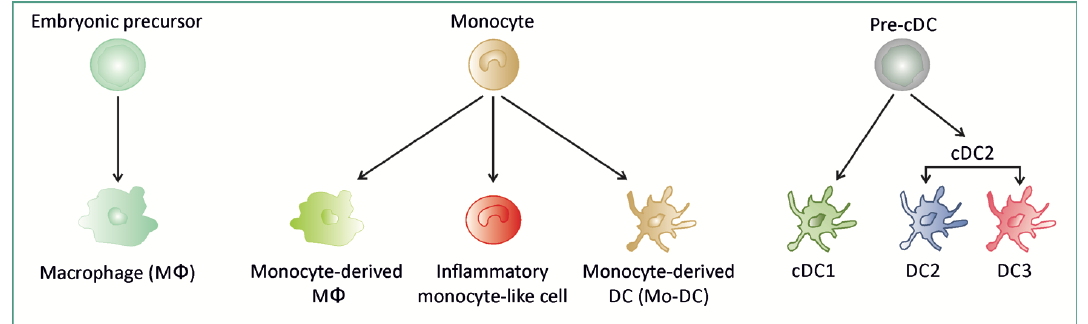
Figure 1. Ontogeny of macrophages, monocyte-derived cells and dendritic cells. Macrophage (M ɸ ) can be derived from embryonic precursor or monocyte. Monocyte can differentiate into M ɸ , dendritic cell (Mo-DC) or tissue inflammatory monocyte-like cell. Conventional dendritic cells (cDC1 and cDC2 that is further subdivided into DC2 and DC3 subsets) originate from a dedicated precursor (pre-cDC).